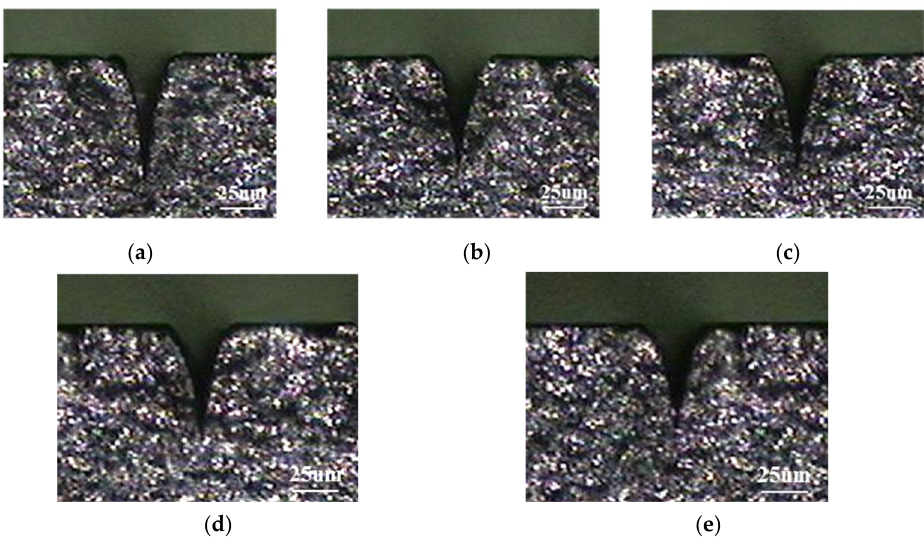
Figure 6. Optical microscope observation of the effect of variation in the scan rate on the kerf depth in laser cutting of PCD workpiece (laser processing parameters were set at average power of 25.5 W, pulse width of 200 ns, and repetition rate of 170 kHz): ( a ) scan rate of 1 mm/s; ( b ) scan rate of 3 mm/s; ( c ) scan rate of 5 mm/s; ( d ) scan rate of 7 mm/s; ( e ) scan rate of 9 mm/s.